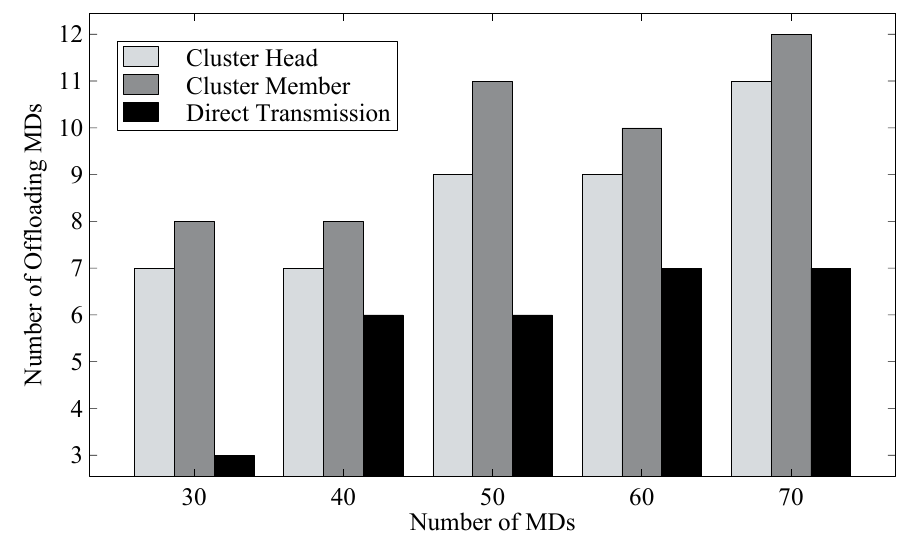
Figure 4. The numbers of cluster heads and members in each channel with 30